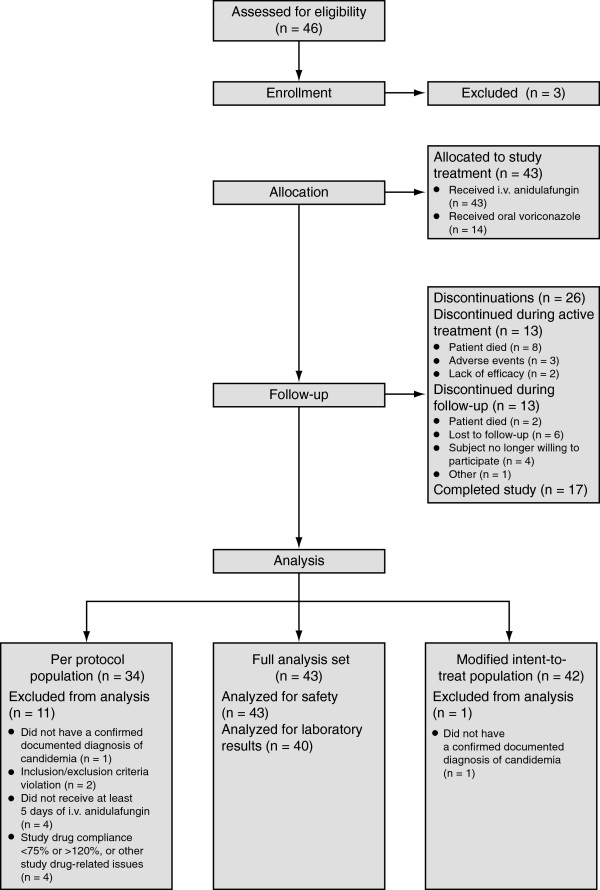
Patient flow chart.